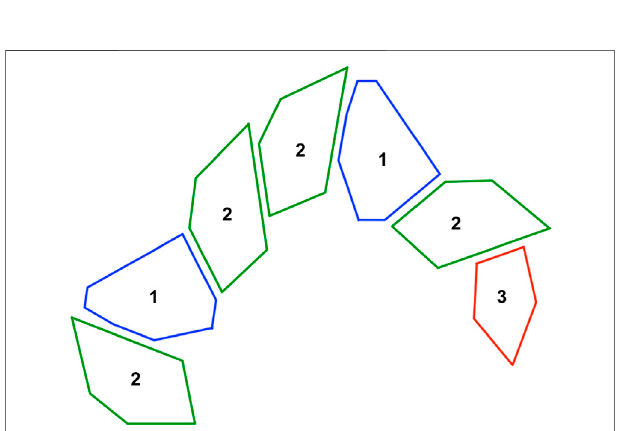
FIGURE 1 | An example of a randomly generated grammar with three base shapes. Arrows represent the transformation eg., each occurrence of shape three is replaced with a combination of shapes 2 and 3 as given by the rule. Orientations have been changed in some cases depending on connecting edges.